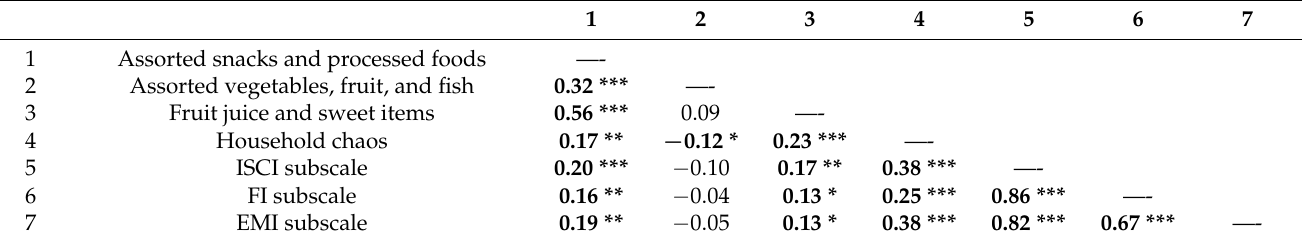
Table 3. Pairwise Bivariate Correlations Among all Model